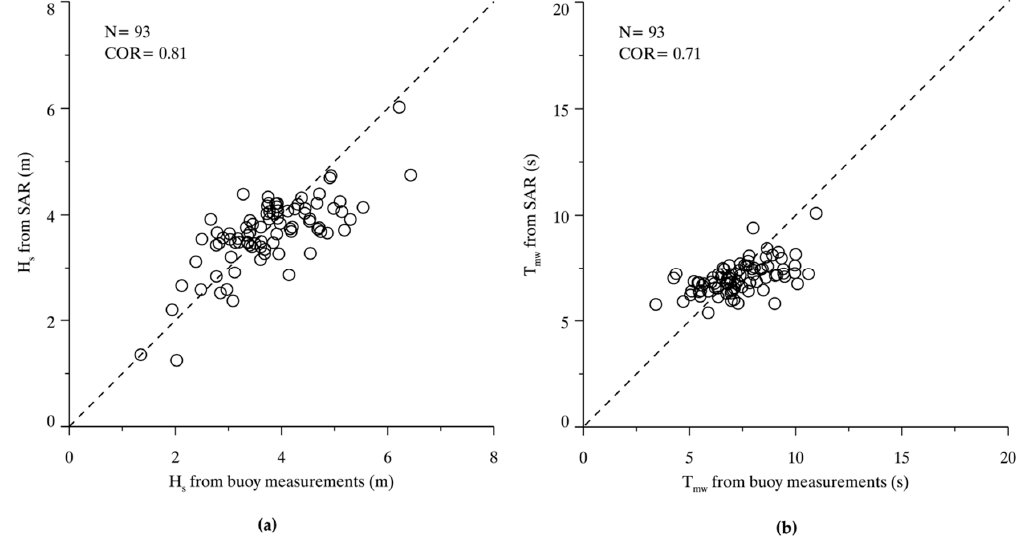
Figure 9. Fitted wave parameters from total 93 cases and the corresponding buoy measurements. ( a ) H s ; and ( b ) T mw .